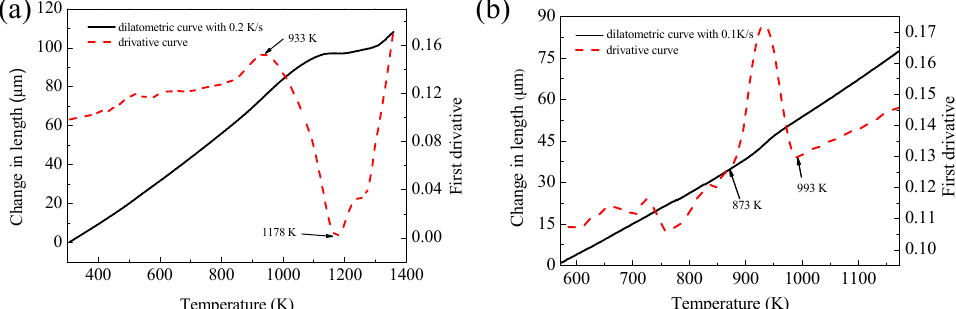
Figure 2. Dilatometric curves and corresponding derivative curves of Ti-17 alloy during heating ( a ) and cooling ( b ).